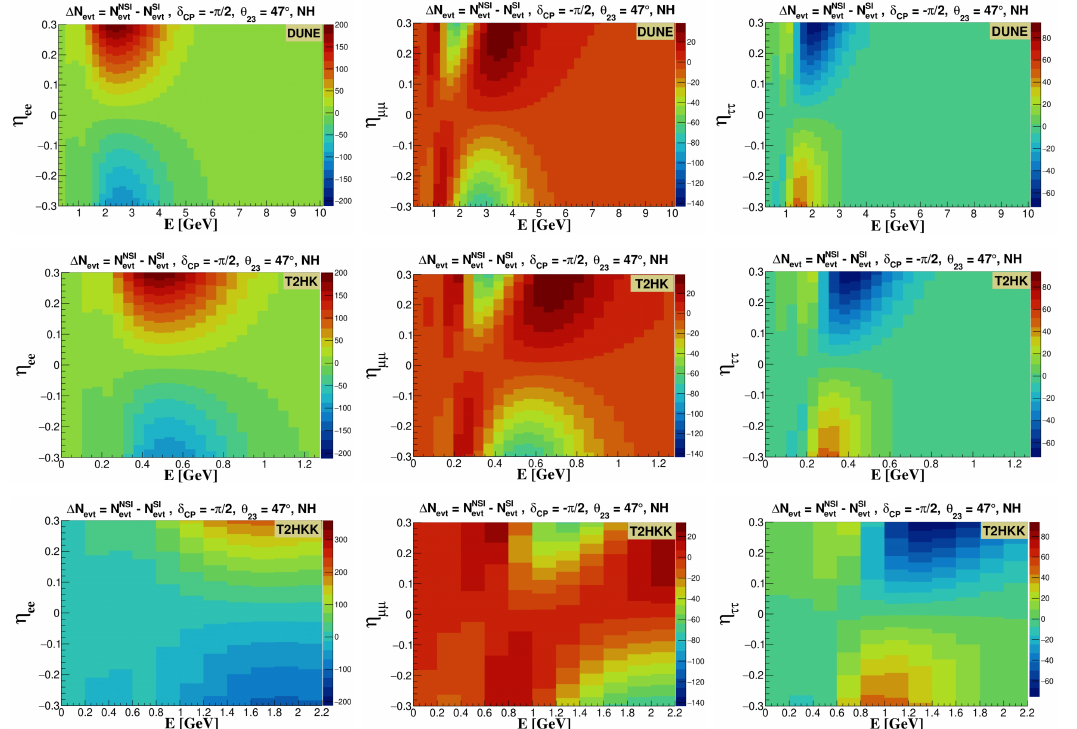
Figure 4 . The variation of ∆ N evt of DUNE (top-row), T2HK (middle-row) and T2HKK (bottom- row) as a function of neutrino energy at fixed δ η αβ ∈ [ − 0 . 3 , 0 . 3] . In the figure the left-column is for non-zero η ee , the middle-column is for non-zero η µµ and the right-column is for non-zero η ττ